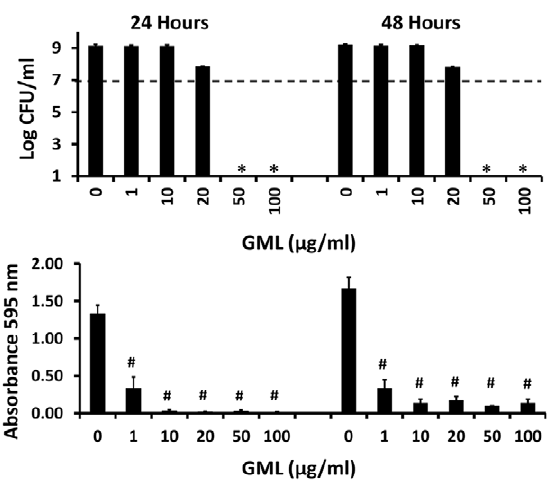
Figure 8. Effect of GML on non-typable Haemophilusinfluenzae cultured in biofilms. Haemophilus influenzae was cultured for 24 and 48 hours in a 96 well microtiter plate. In one set of three wells for the microbe, the wells were agitated 3 times by pipetting up and down and then supernates removed for plate counting to determine CFUs/ml. * indicates significant mean reduction compared to starting inoculum mean at p , 0.001. Dashed line indicates starting inoculum size. Subsequent to removing bacterial cells and washing three times with phosphate-buffered saline, the wells were treated with crystal violet for 30 min. The wells were then washed three times with phosphate- buffered saline to remove unbound crystal violet. Finally, the wells were treated with ethanol to solubilize biofilm-associated crystal violet. Absorbances at 595 nm were determined by an ELISA reader. # indicates significant mean reduction in absorbance at 595 nm wavelength between no GML and GML-treated wells at p , 0.01.